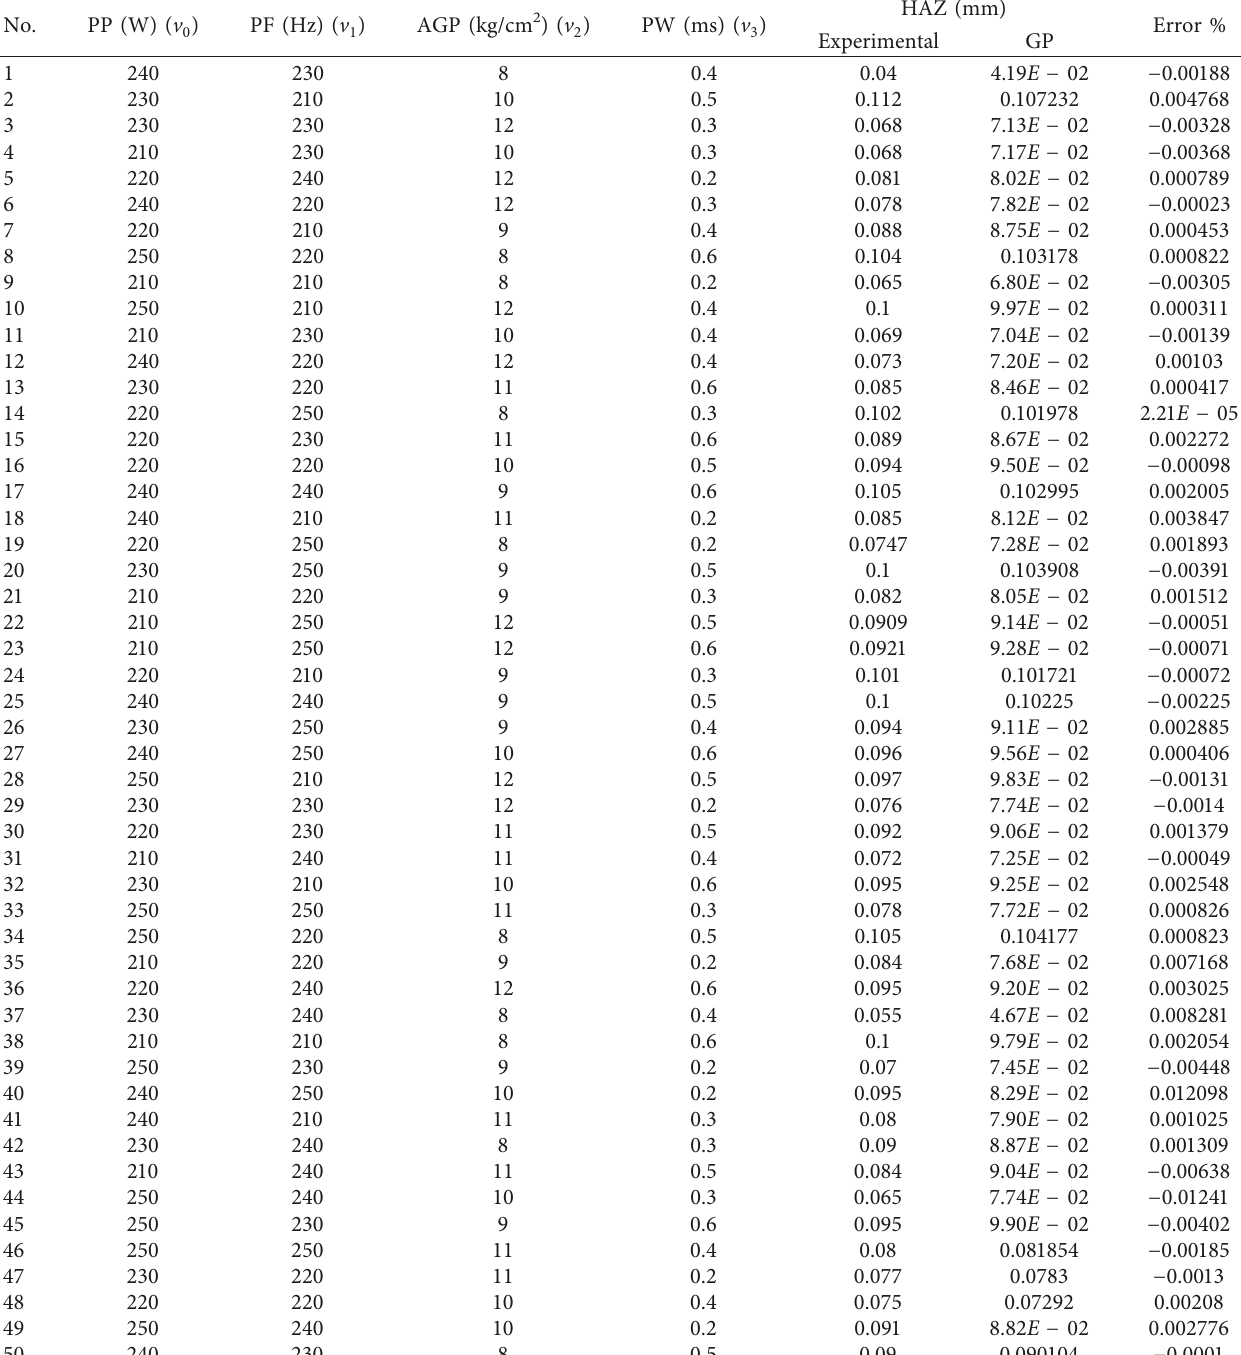
Table 3: Comparison between experimental and predicted values of HAZ at R 2 �